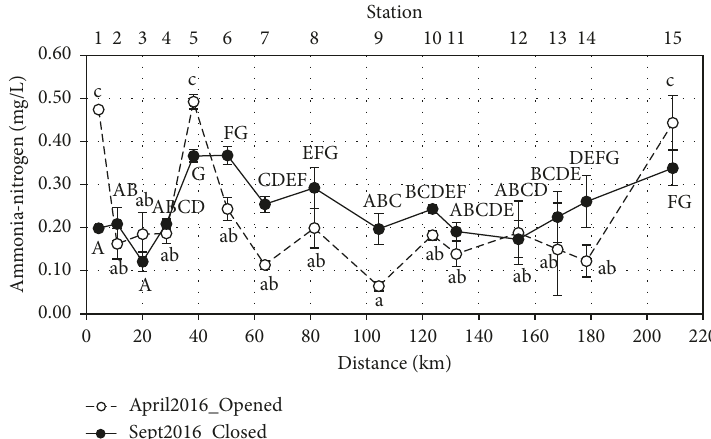
Figure 9: Ammonia-nitrogen at the 15 stations downstream of Bakun Hydroelectric Dam during opened spillway ( o ) and closed spillway ( • ). The same letter indicates no significant difference ( p > 0 . 05).